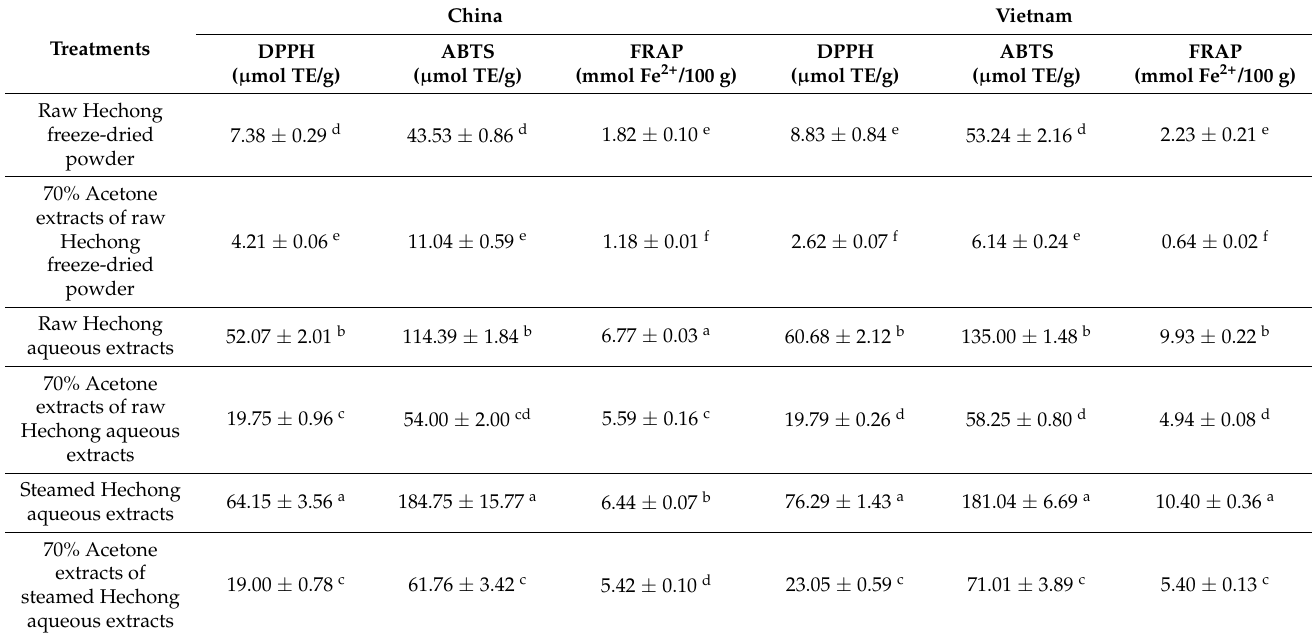
Table 1. Antioxidant activities of extracts and hydrolysate from Hechong grown in China and